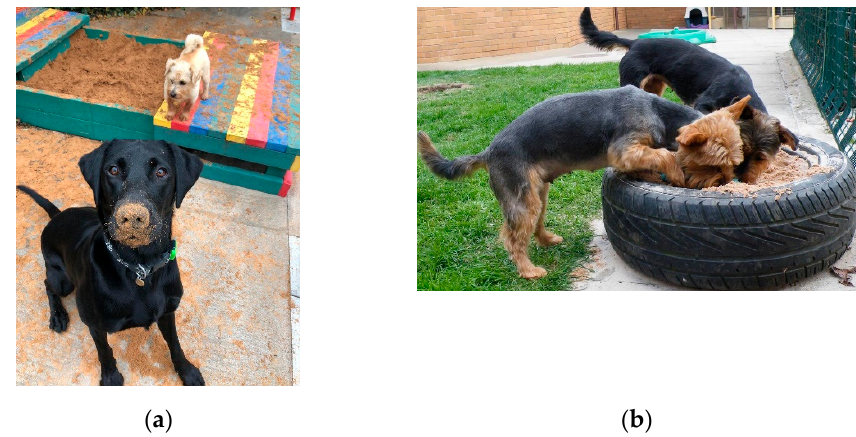
Figure 3. ( a ) Dogs having playtime in a Marmax sandpit with a sliding cover at Waltham. ( b ) Dogs interacting with a sand-filled tyre at Waltham.